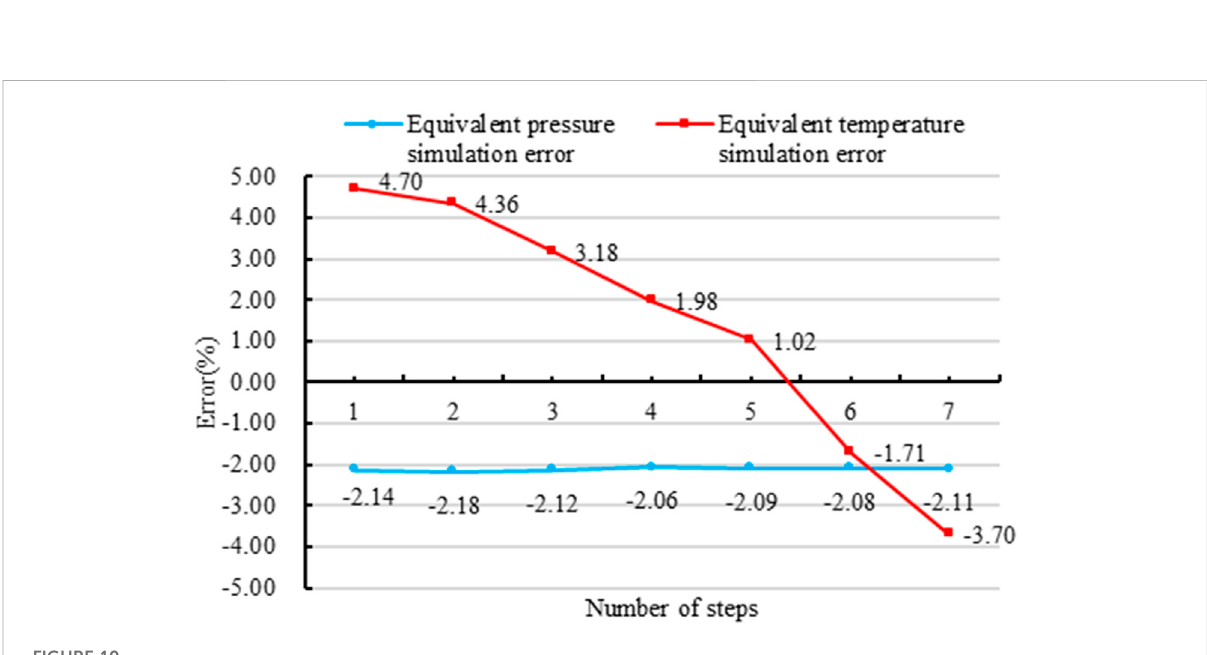
FIGURE 9 Equivalent temperature loading error analysis chart.